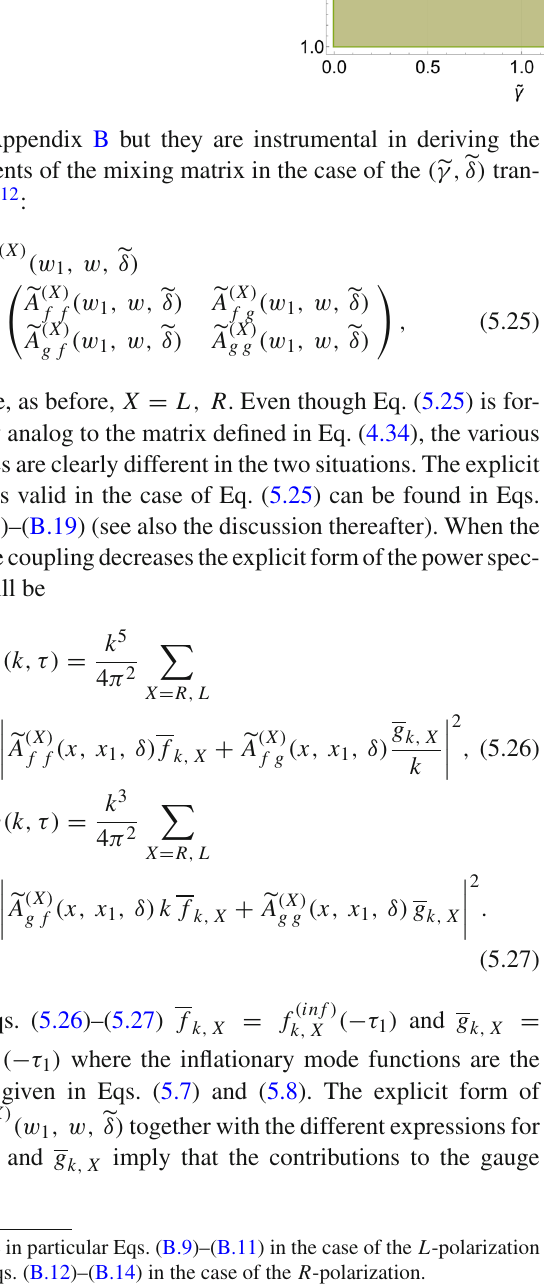
Fig. 2 The critical density bounds during the quasi-de Sitter stage of expansion are illustrated in the ( (cid:8) γ, η) plane. As in difference between the left and right plots comes from a different value of the tensor to scalar ratio r T entering the estimate of ( H / M P